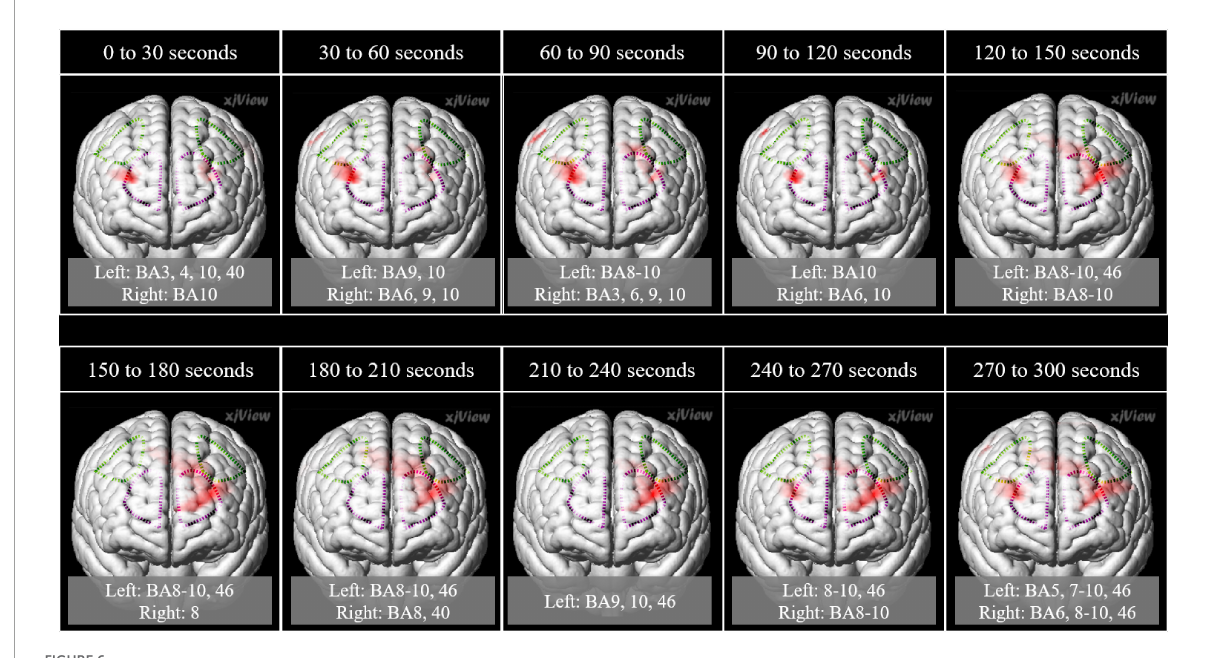
FIGURE6 Comparison of the hemodynamic response during the chewing of the two gums. Parametric mapping analysis (paired t -test; uncorrected p < 0.05) was performed using the area under the curves (AUCs) (palatable gum vs. unpalatable gum). Areas with significant differences in Unpalatable > Palatable are shown. 3D image was obtained from images obtained every 30 s using MRIcroGL (https://www.mccauslandcenter.sc.edu/mricrogl/). Regions of interest (ROI) in the prefrontal cortex are circled by dotted lines. Purple dotted line: Frontopolar cortex, green dotted line: Dorsolateral prefrontal cortex and includes frontal eye